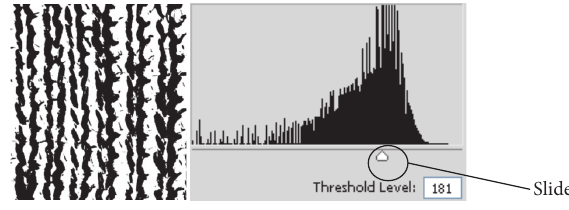
Figure 2: Black mask